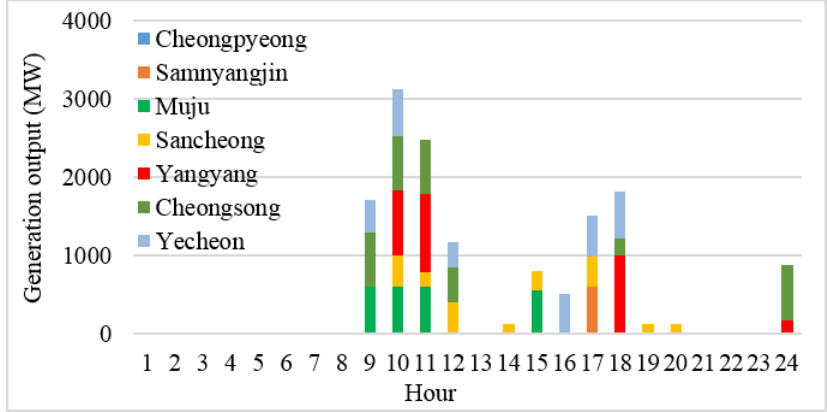
Figure 1. The calculated generation schedule for the peak-load day in 2016.